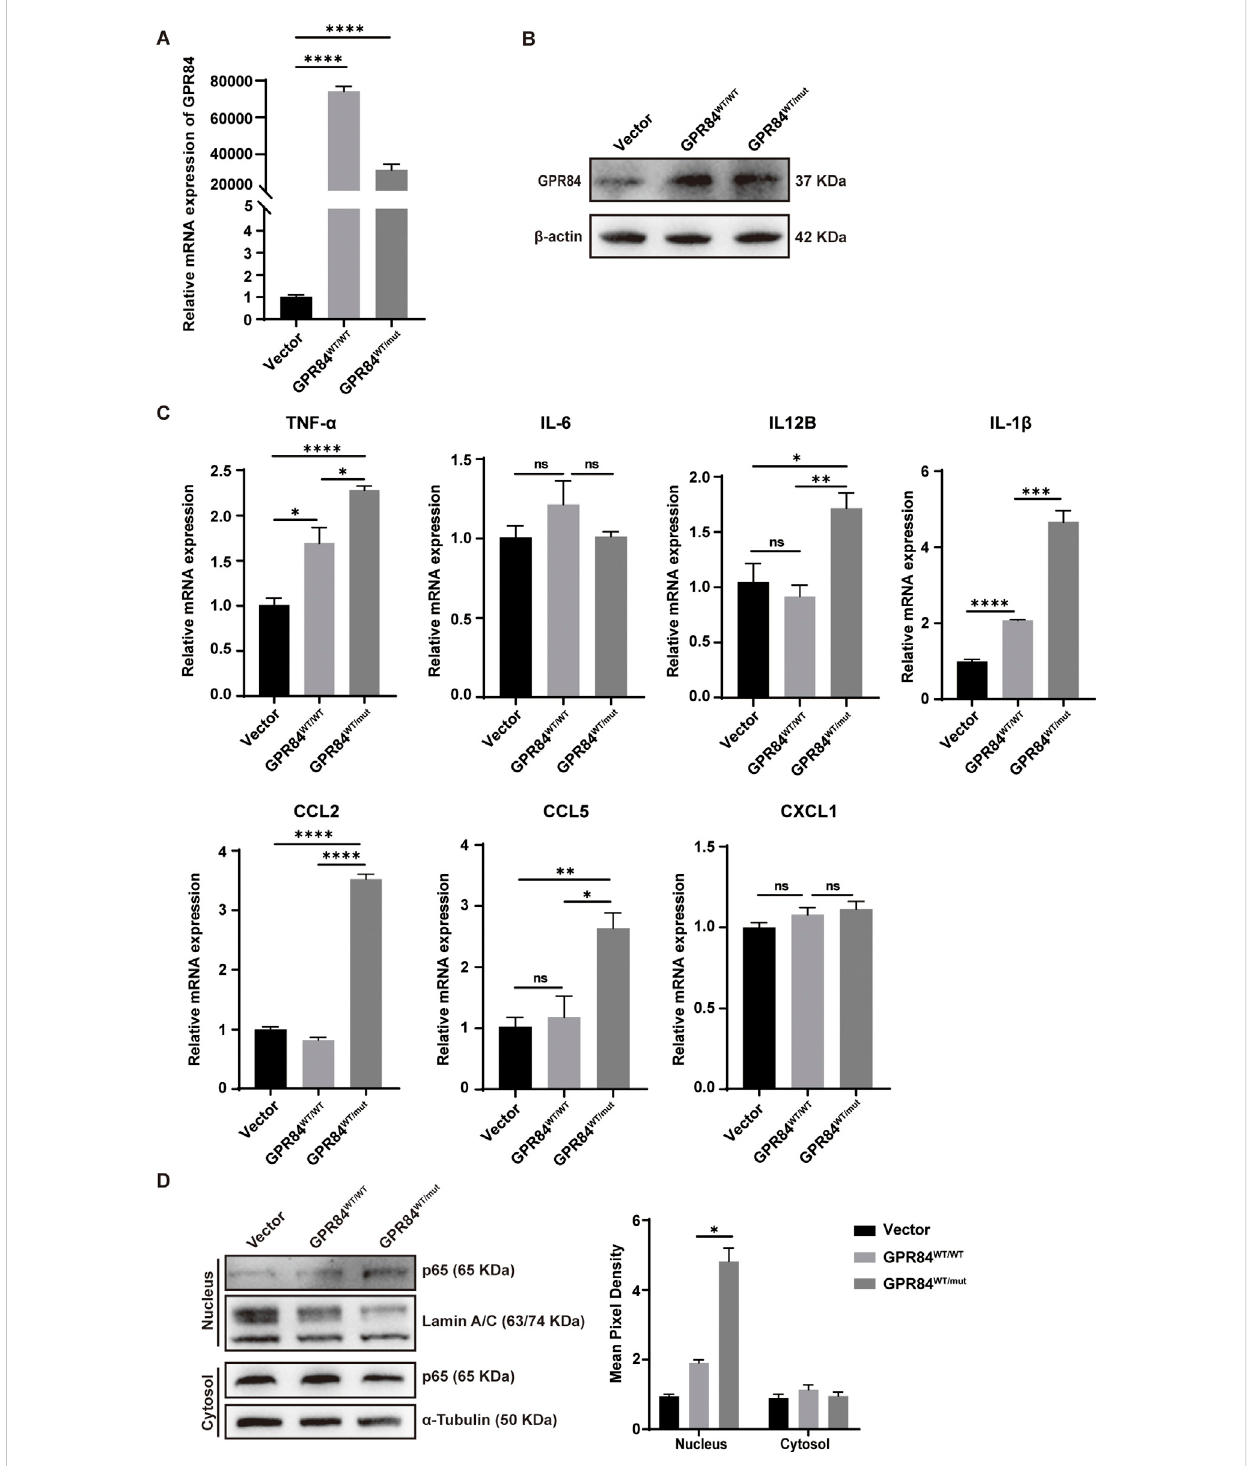
FIGURE 5 GPR84 Y370H variantpromotesthein fl ammatoryresponseinhumanovariangranulosacells. (A,B) TheconstructionofGPR84(shownasGPR84 WT/WT ) and GPR84 Y370H (shown as GPR84 WT/mut ) overexpressed KGN cells (human granulosa-like tumor cell line) were veri fi ed by qRT-PCR and Western blot respectively. (C, D) The GPR84 WT/WT and GPR84 WT/mut overexpressed KGN cells were treated with LPS (0.1 μ g/mL) for 2 h before stimulation with lauric acid (200 μ M) for 24 h. (C) The mRNA level of in fl ammatory cytokines (TNF- α , IL-6, IL12B, IL-1 β ) and chemokines (CCL2, CCL5, CXCL1) were measuredbyqRT-PCR. (D) Theproteinlevelofp65innucleuswereincreasedinGPR84 WT/mut groupcomparedwithGPR84 WT/WT group.LaminA/Cand α - Tubulin were used as loading controls in nucleus and cytosol respectively. Data are represented as mean ± SEM. Statistical signi fi cance was assessed by two-tailed unpaired t -test. * p < 0.05, ** p < 0.01, *** p < 0.001, **** p <